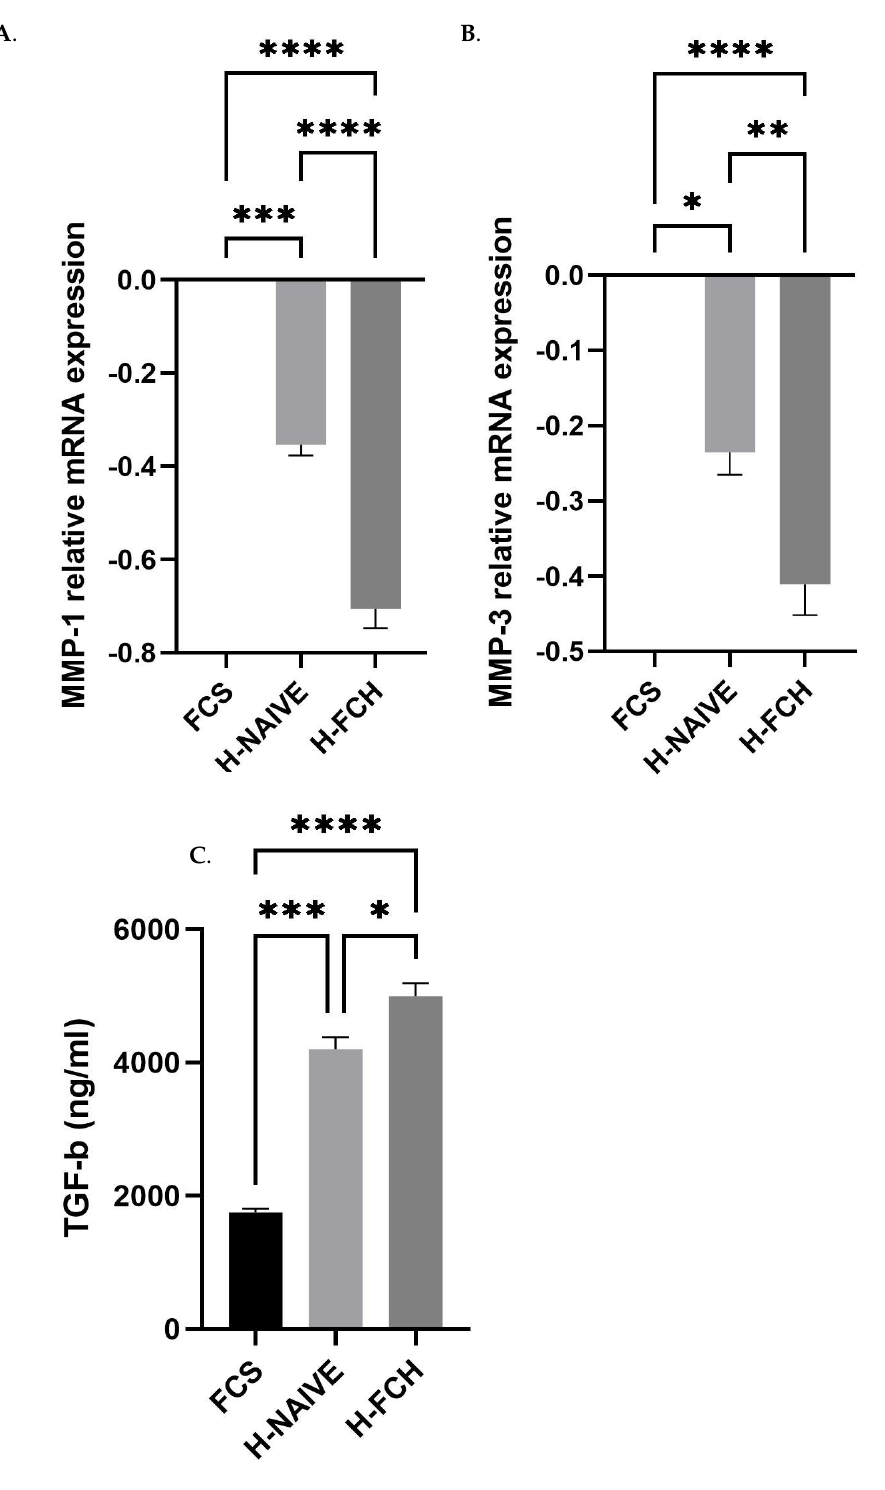
Figure 6. Primary human dermal fibroblasts (HDFs—adult) were incubated in the presence of either fetal calf serum or human naive serum (H-NAIVE) or human serum enriched with metabolites deriving from FCH ingestion (H-FCH). MMP1 and MMP3 mRNA relative expression ( A , B ). TGF- β release by HDFs ( C ). Measures were performed in quadruplicates per condition/volunteer ( n = 10 volunteers). Values are presented as the means ± SEM. The differences were considered statis- tically significant at p < 0.05 with * for p < 0.05; ** for p < 0.01; *** for p < 0.001 and **** for p <